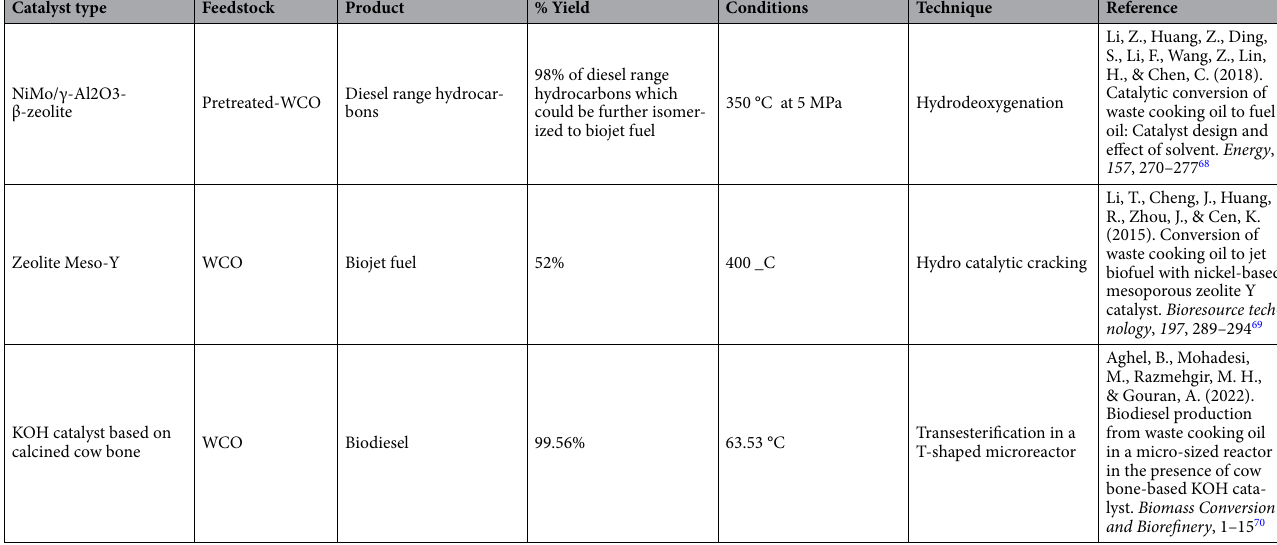
Table 6. Previous Studies Findings in the Catalytic Conversion of Vegetable Oils into Liquid Biofuels.